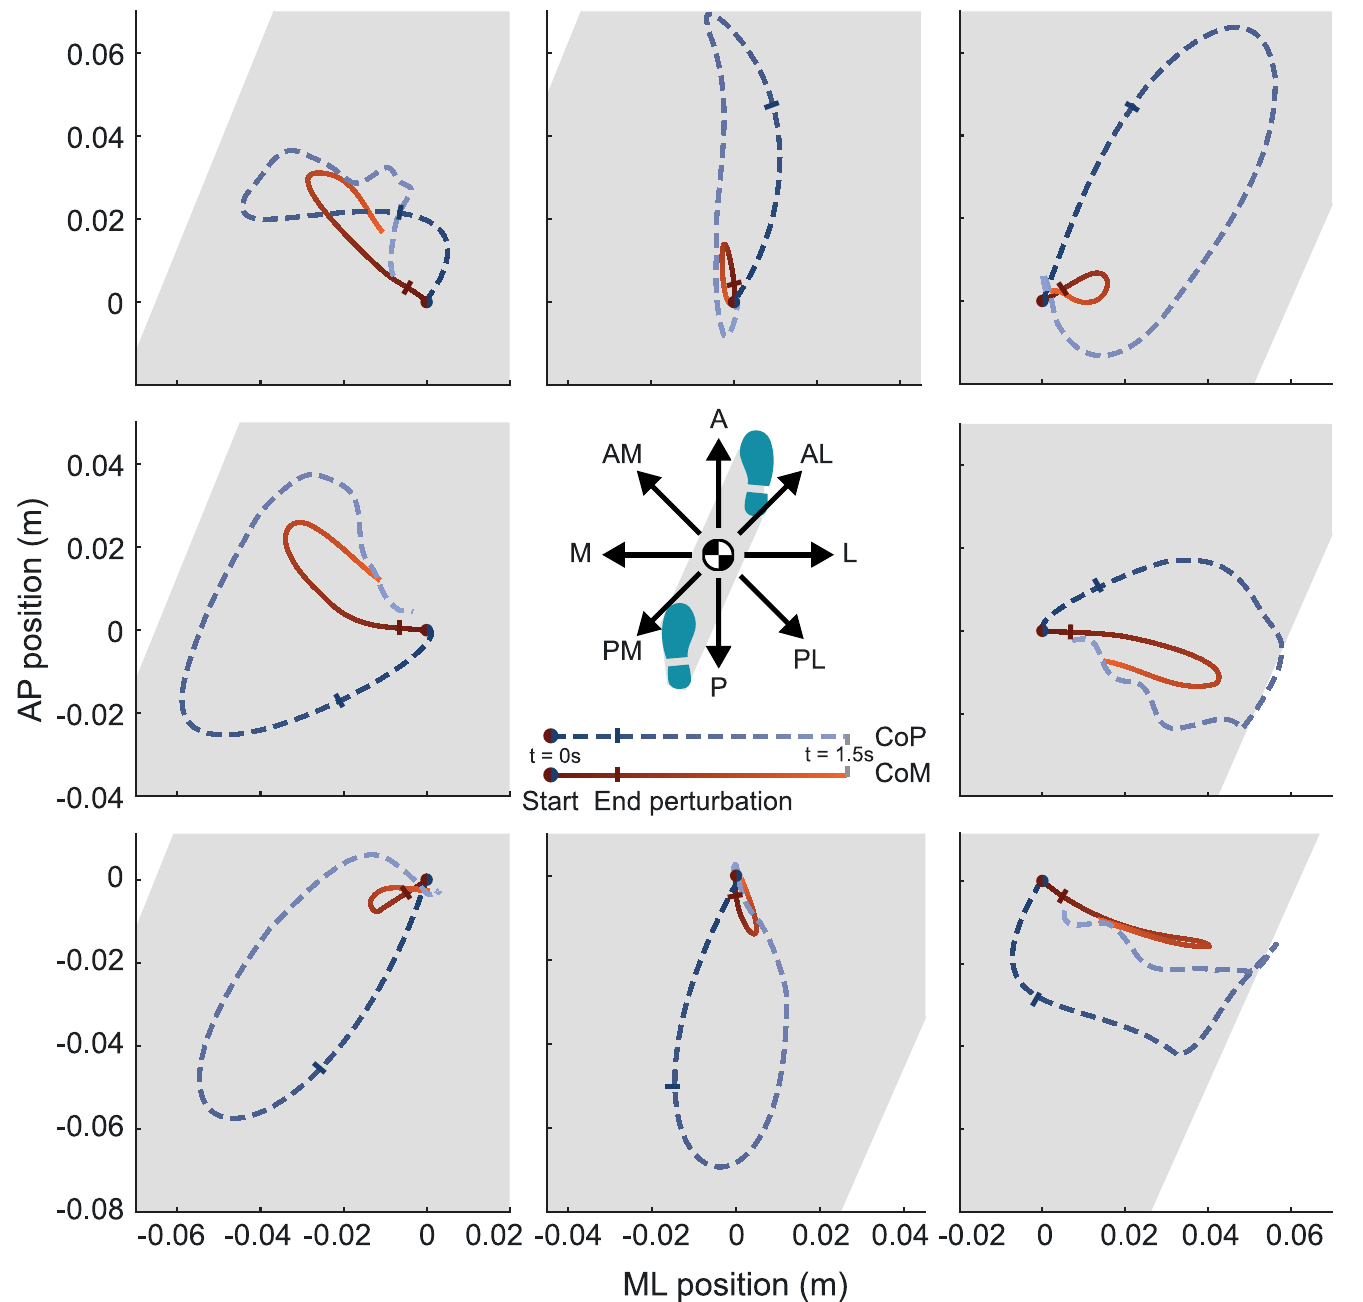
Fig 3. Top-down view CoM and CoP. Top-down view of the centre of mass (CoM in red) and centre of pressure (CoP in blue) trajectories after a 9% magnitude perturbation given in the direction indicated in the middle of the figure. A trajectory of 1.5 s is presented, with the start of the perturbation (t = 0 s) indicated with a dot and the end of the perturbation with a perpendicular line. The shaded area indicates the base of support. The presented results are the averages across all participants.